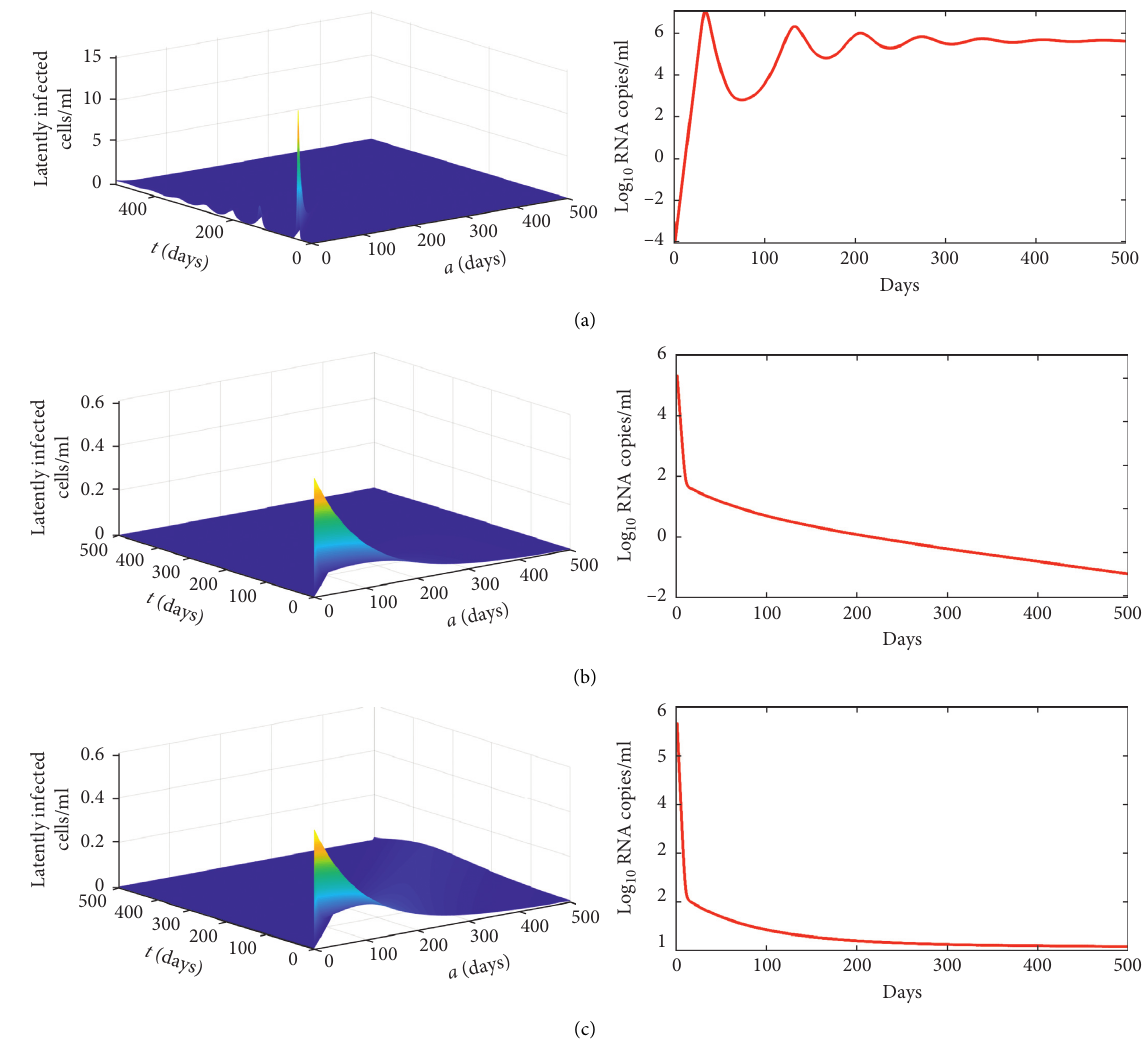
Figure 3: Dynamics of the virus and latent reservoir predicted by model (33). (a) The latently infected CD4 + Tcells and viral load reach an infected equilibrium of model (33) without treatment and ρ ( a ) − δ L ( a ) � 0 . 5 a Tcells and viral level are predicted to go extinct under treatment: ε � 0 . 99 and ρ ( a ) − δ L ( a ) � 0 . 1 a and viral load persist at low levels under therapy: ε � 0 . 99 and ρ ( a ) − δ L ( a ) � a